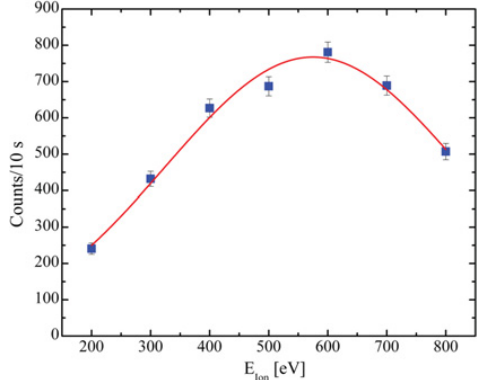
Figure 15. Dispersion of the electric deflector for O +